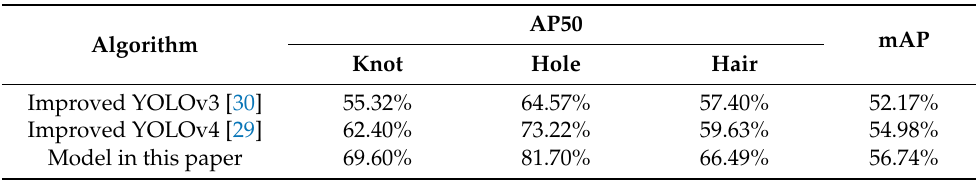
Table 3. Comparison of improved